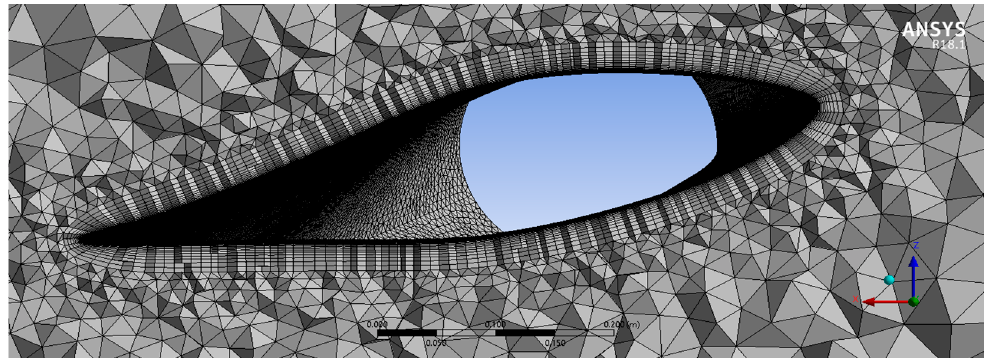
Figure 9. A sample mesh over the wind turbine blade.